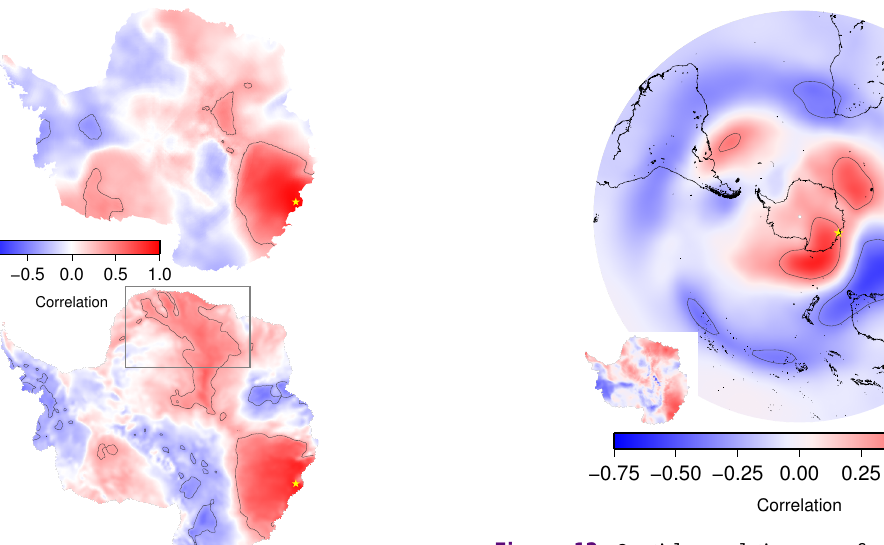
Figure 12. Spatial correlation map for ERA-Interim 500hPa geopotential height (Dee et al., 2011) and power-law-based snow accumulation rate for 1979–2012CE. Contours show the 95% con- fidence level while the yellow star denotes the location of DSS. In- set: third principal component of the Southern Hemisphere 500hPa geopotential height correlated with power-law-based snow accumu- lation rate for